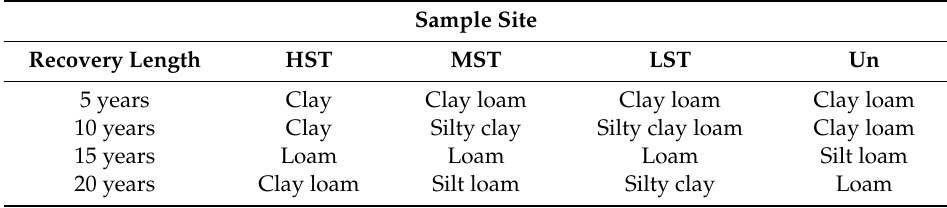
Table 2. Soil texture classes at a depth of 0–100 mm for skid trails after di ff erent recovery lengths since the most recent harvest operation on skid trails with di ff erent tra ffi c intensities. Un = Undisturbed